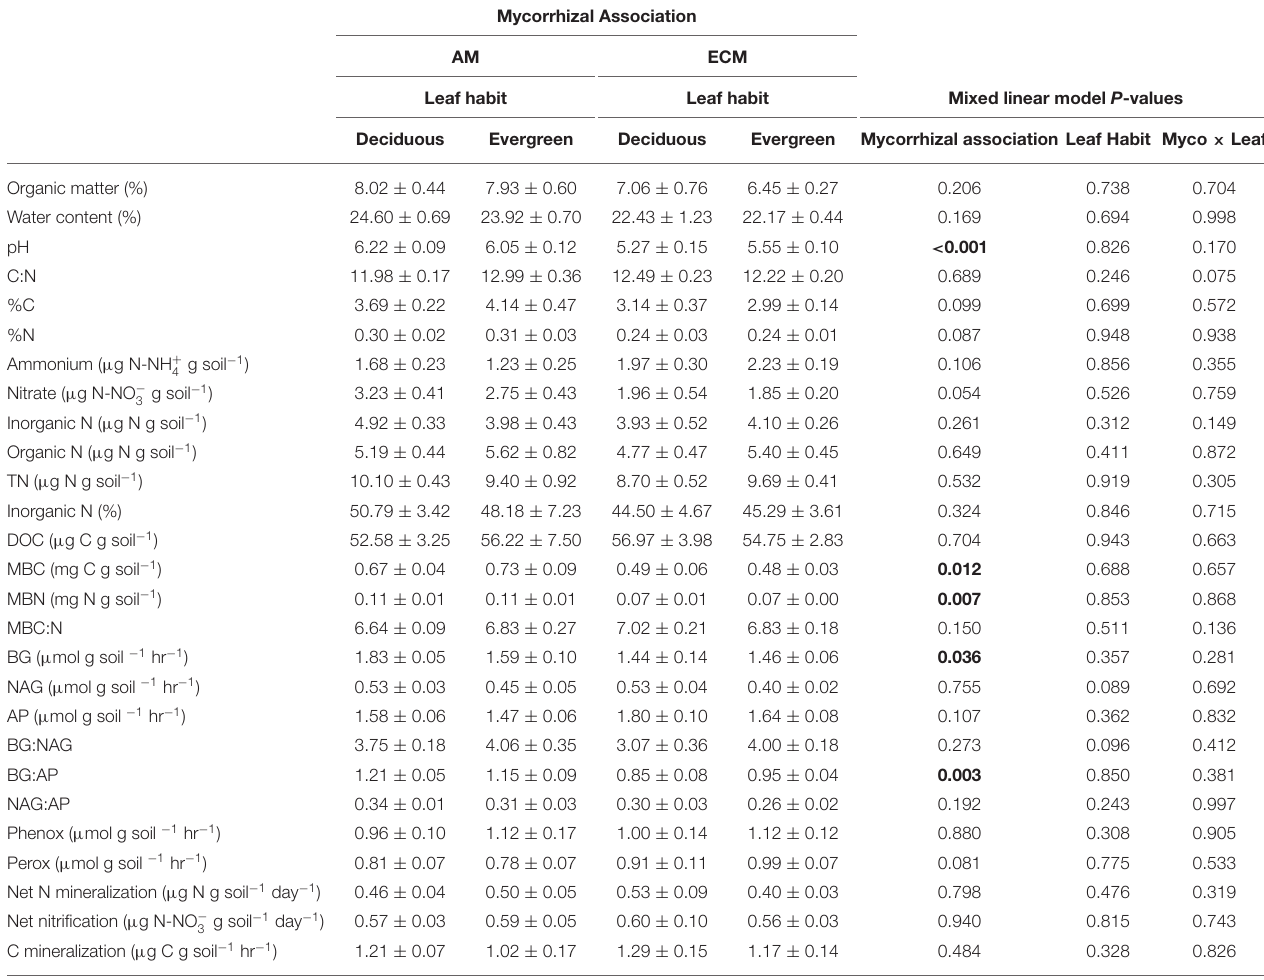
TABLE 3 | Properties of 5–15cm soils in AM deciduous, AM evergreen, ECM deciduous, and ECM evergreen forestry plots at The Morton